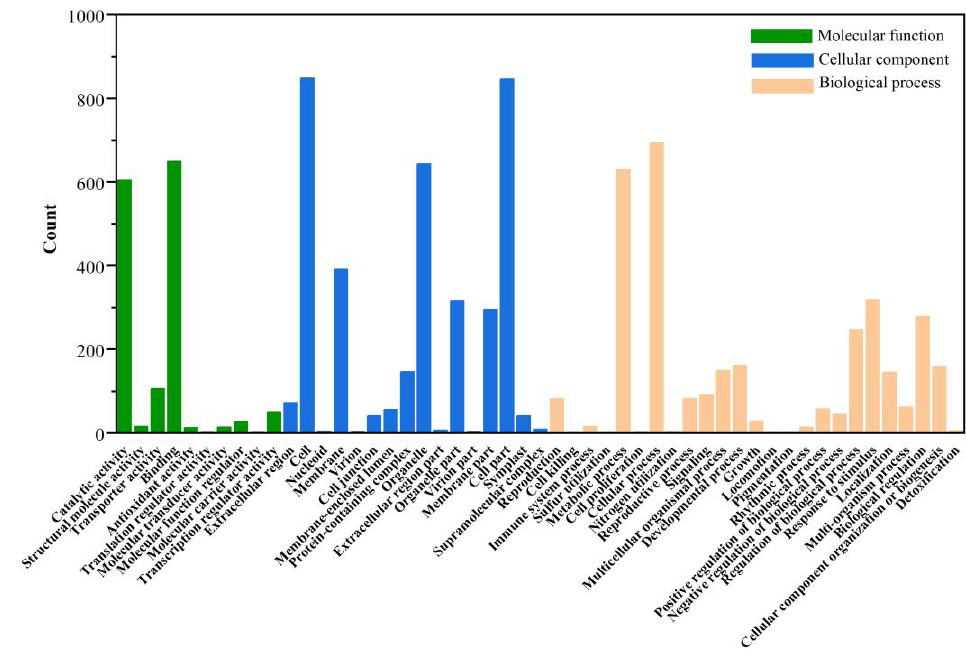
Figure 10. The GO classification of different genes between ASY and SY in F. cirrhosa . ASY: aberrant six-year samples. SY: six-year samples.